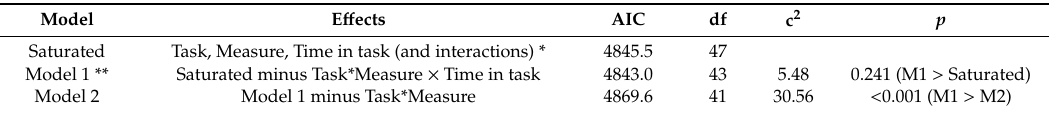
Table 1. Models resulting from hierarchical fitting of valence, arousal, and reported perceived exertion (RPE) scores.